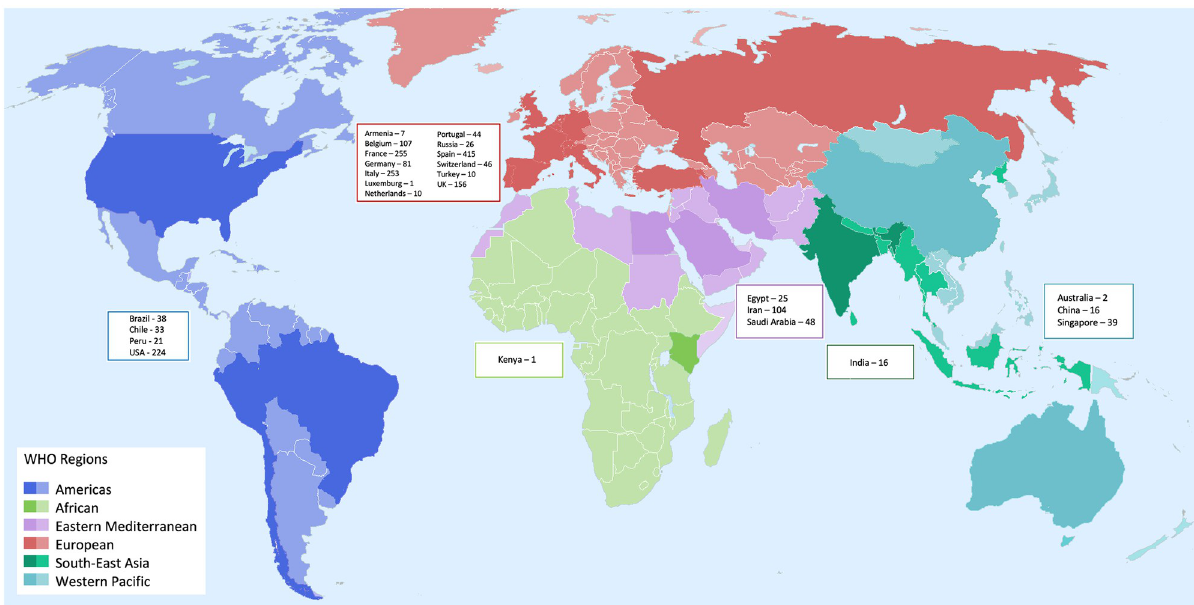
Fig 3. Locations of 1979 patients from 83 studies providing individual patient data (IPD). WHO regions are depicted in different colours. Countries from which we received IPD are depicted in a darker shade. Country names and numbers of patients for which we had IPD are displayed in boxes, grouped according to